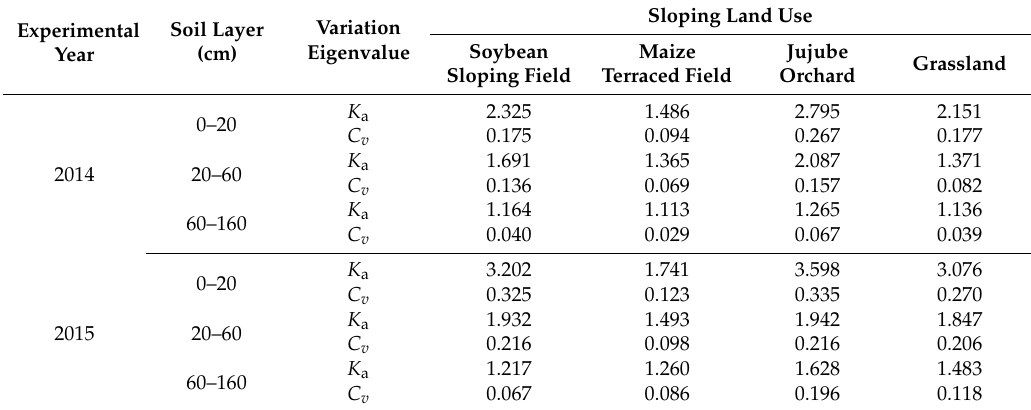
Table 3. Statistical analysis of soil moisture changes in profile under di ff erent sloping land uses. Variation Soil Layer (cm)